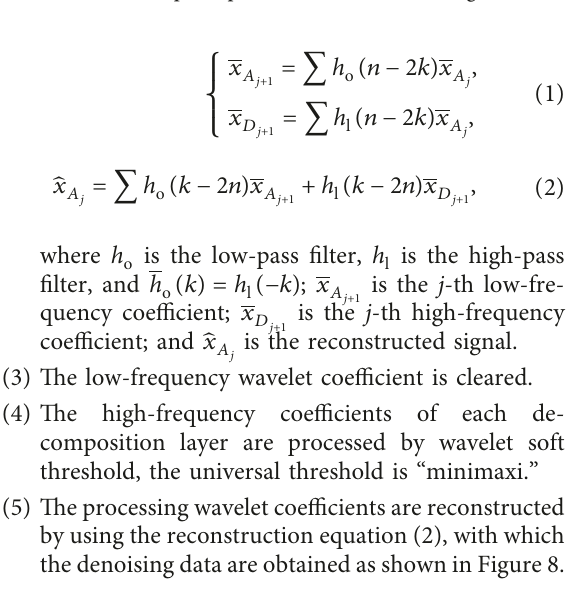
Figure 1: (a) The principle of the unsaturated magnetic excitation detection method. (b) Data acquisition platform schematic.